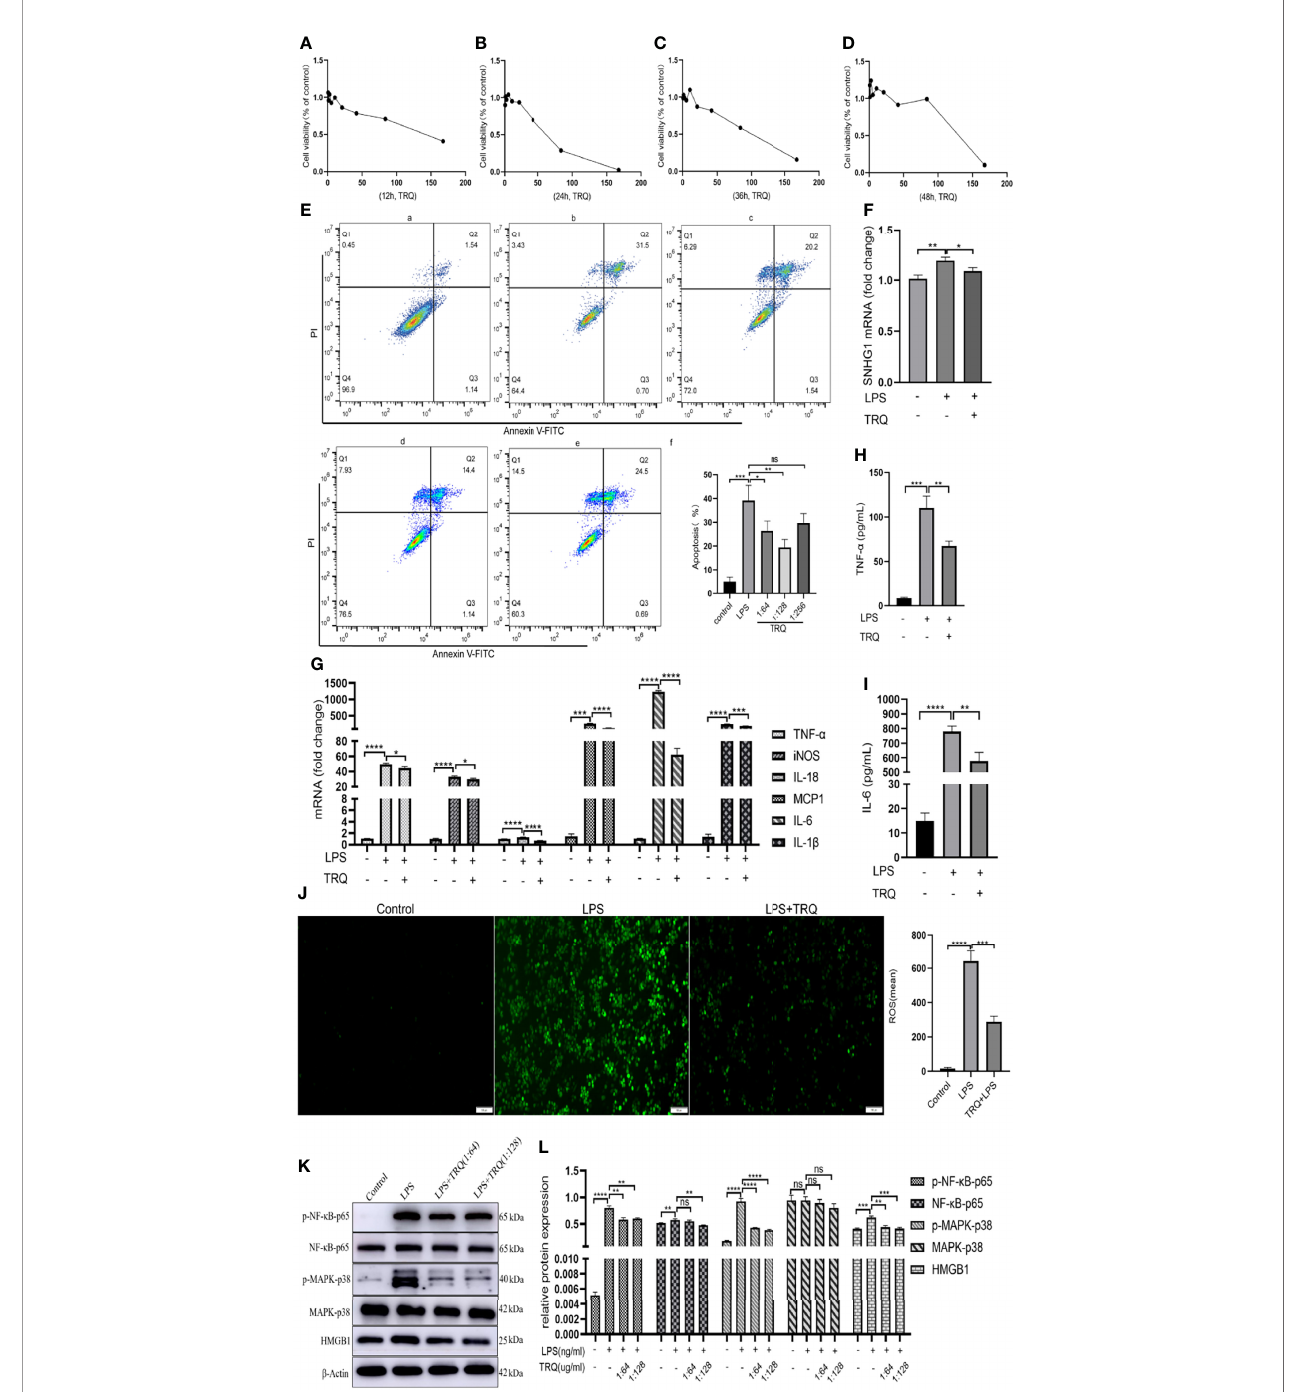
FIGURE 7 | Tanreqing injection (TRQ) inhibits in fl ammatory responses in LPS-activated macrophages. (A – D) The toxicity of TRQ at different concentrations in RAW264.7 cells, as determined by CCK-8 assay. (E) Apoptosis assays of RAW264.7 cells treated with TRQ at concentrations of 1:64, 1:128 and 1:256. (F) The expression of SNHG1 in LPS-activated macrophages after TRQ treatment, as determined by qRT-PCR. (G) Expression of proin fl ammatory cytokines (TNF- a , iNOS, IL-18, MCP-1, IL-6 and IL-1 b ) in LPS-activated RAW264.7 cells after TRQ treatment, as determined by qRT-PCR. (H, I) Expression of proin fl ammatory cytokines (TNF- a , IL-6) in LPS-activated RAW264.7 cells after TRQ treatment, as determined by ELISA. (J) Production of ROS in RAW264.7 cells after LPS and TRQ treatment (magni fi cation, ×100, scale bar, 100 m m). (K, L) Relative protein levels of p-NF- k B-p65, NF- k B-p65, p-MAPK-p38, MAPK-p38 and HMGB1 were detected in LPS- induced RAW264.7 cells treated with TRQ. Data are indicated as the mean ± SD, ns P ≥ 0.05, * P <0.05, ** P <0.01, *** P <0.001, **** P